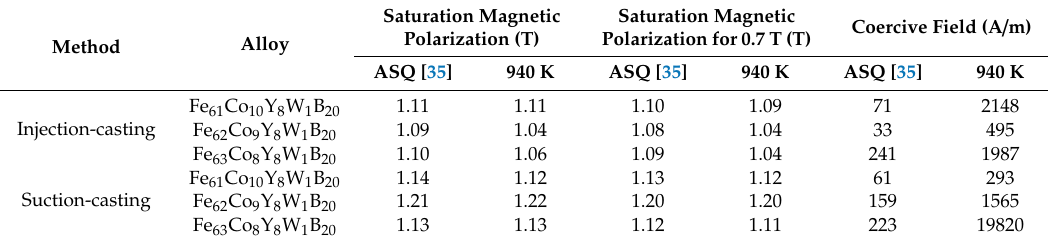
Table 3. The values of saturation magnetic polarization and the coercive field for the investigated